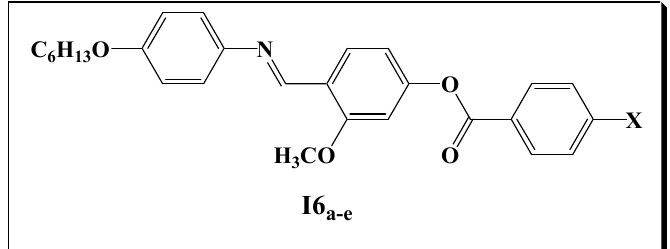
Figure 1. Prepared homologues series, I6 a–e .